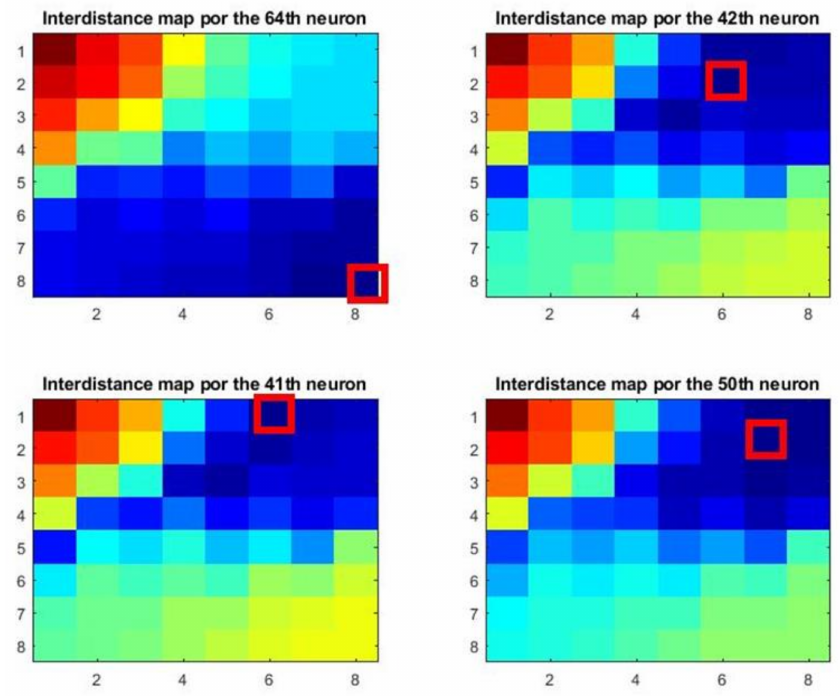
Figure 9. Distance maps of network elements 41, 42, 50 and